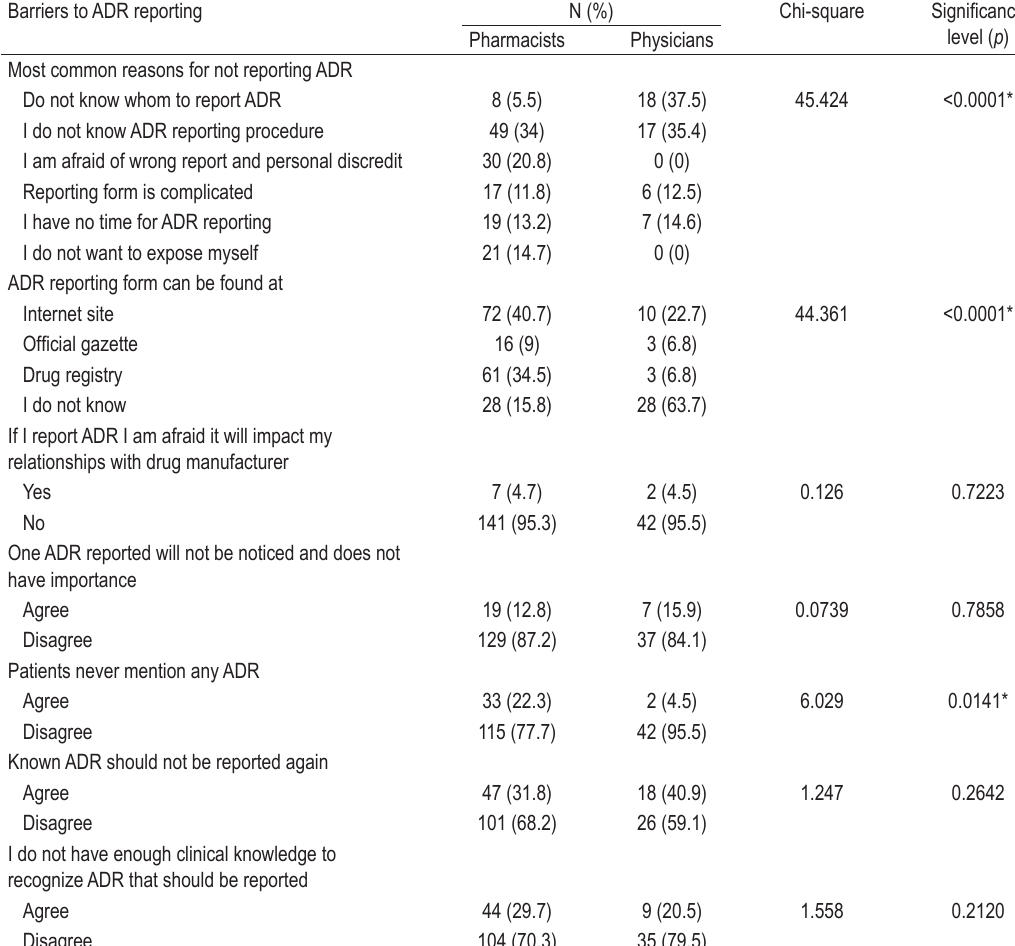
TABLE 3. Barriers and knowledge of ADR reporting reported by the pharmacists and physicians Barriers to ADR